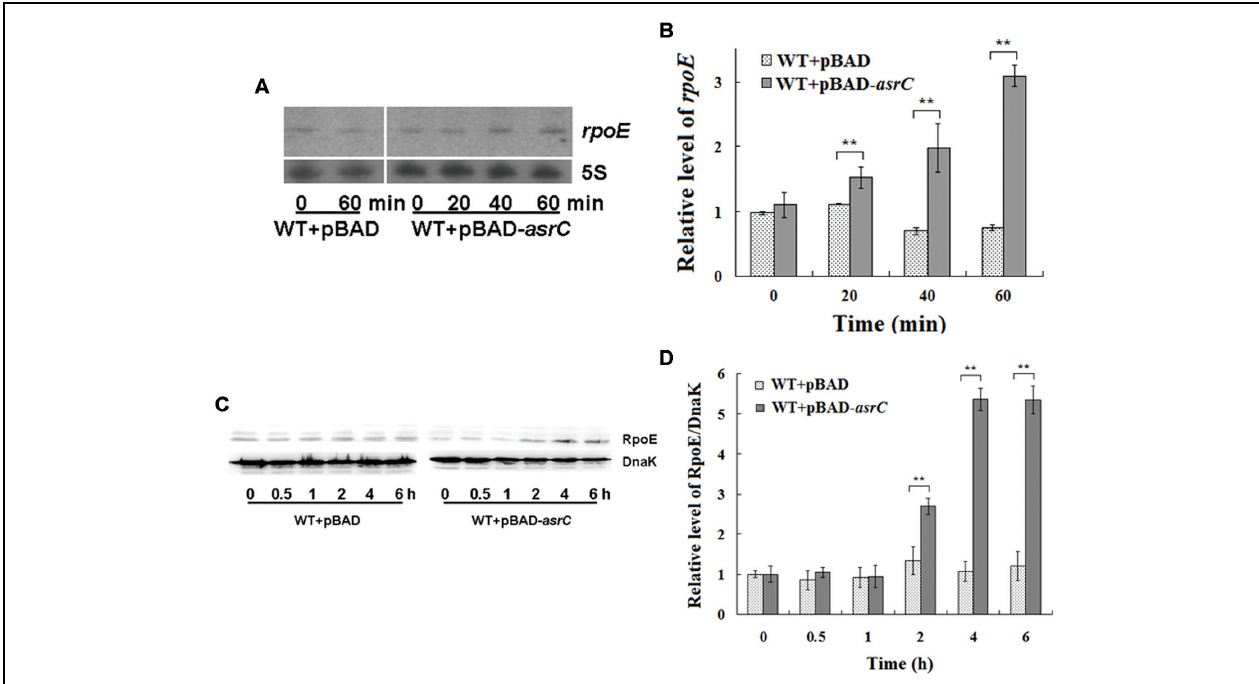
FIGURE 6 | Overexpression of AsrC increased rpoE mRNA and protein. RpoE mRNA assessed by Northern hybridization (A) and qRT-PCR (B) . Total RNAs were isolated from WT + pBAD and WT + pBAD- asrC strains grown to OD 600 0.4 at 0, 20, 40, and 60 min after addition of L -arabinose (0.2% final concentration). Levels of 5S rRNA were the internal reference. (C) Western blot of RpoE protein relative to DnaK in WT + pBAD and WT + pBAD- asrC strains. Representative blots are shown. (D) Quantitation of RpoE protein levels based on Western blots. Experiments were repeated three times and error bars indicate standard deviations. ∗∗ P < 0.01 compared with control